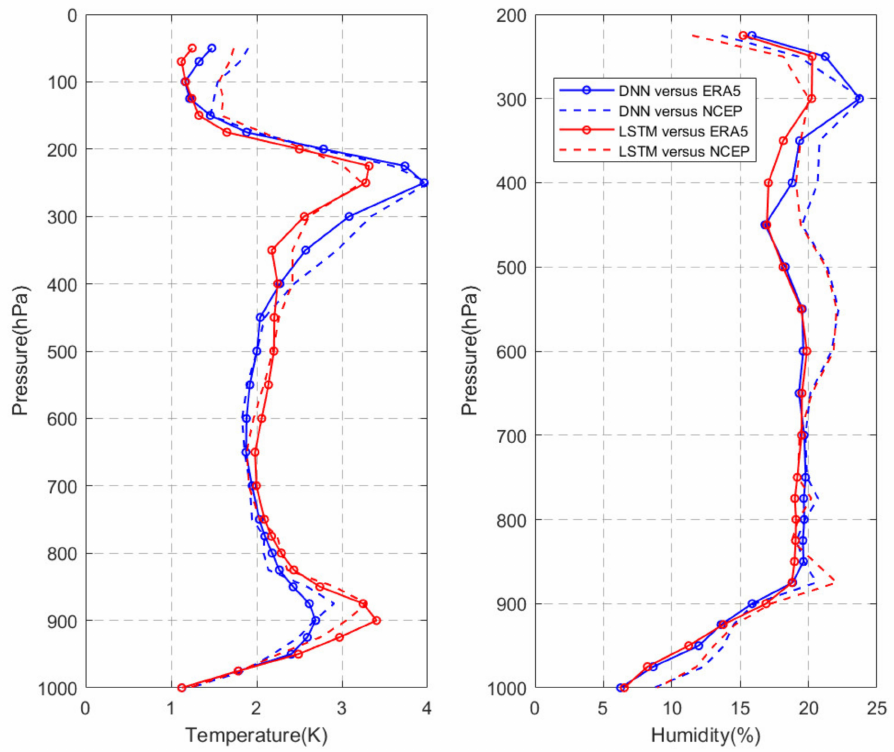
Figure 11. The retrieval RMSEs of the DNN and LSTM models with respect to ERA5 and NCEP reanalysis data over mixed ice–water in June 2021.